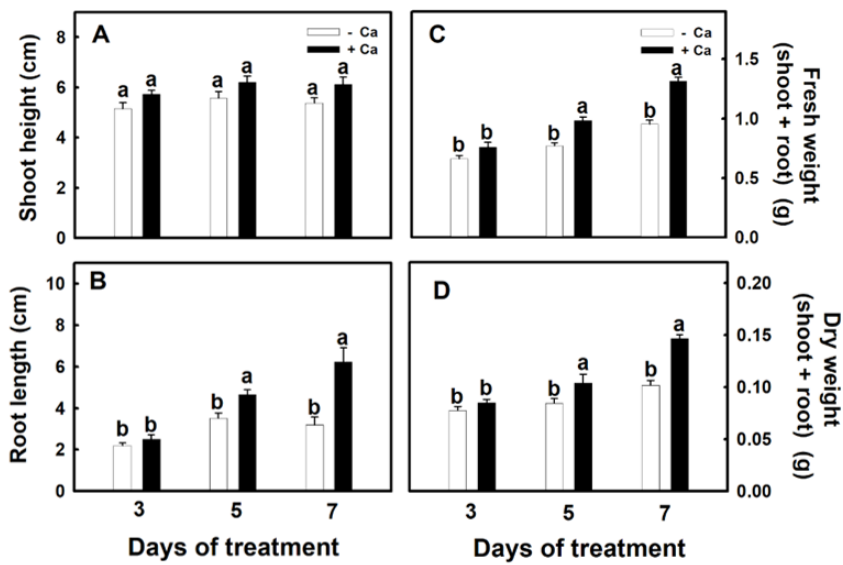
Figure 2. The effect of calcium carbonate on the growth characters of Djulis sprouts. The 7-d-old djulis plants were treated with 5 mM CaCO 3 for 3, 5, and 7 days. Shoot height ( A ), root length ( B ), root fresh weight ( C ), and root dry weight ( D ) were investigated. Bars show means ± SE ( n = 10), repeated three times. Values with the same letter are not significantly different at p < 0.05.